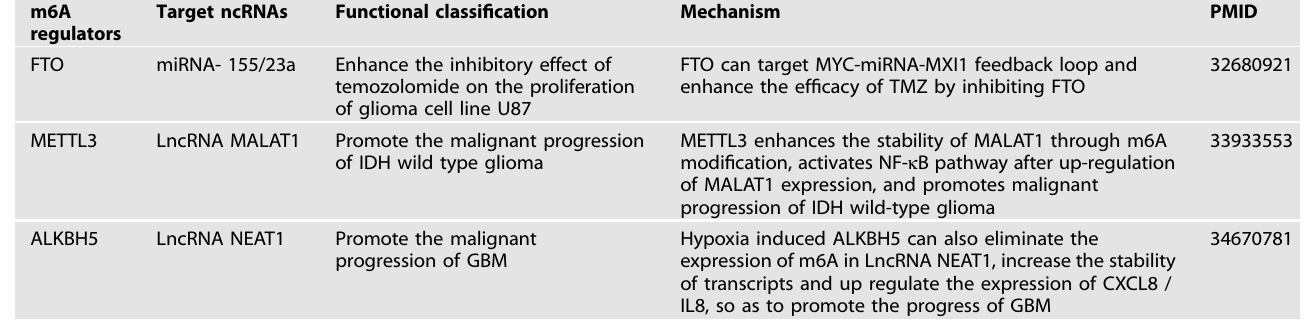
Table 1. Role of m6A regulators targeting ncRNAs in glioma.